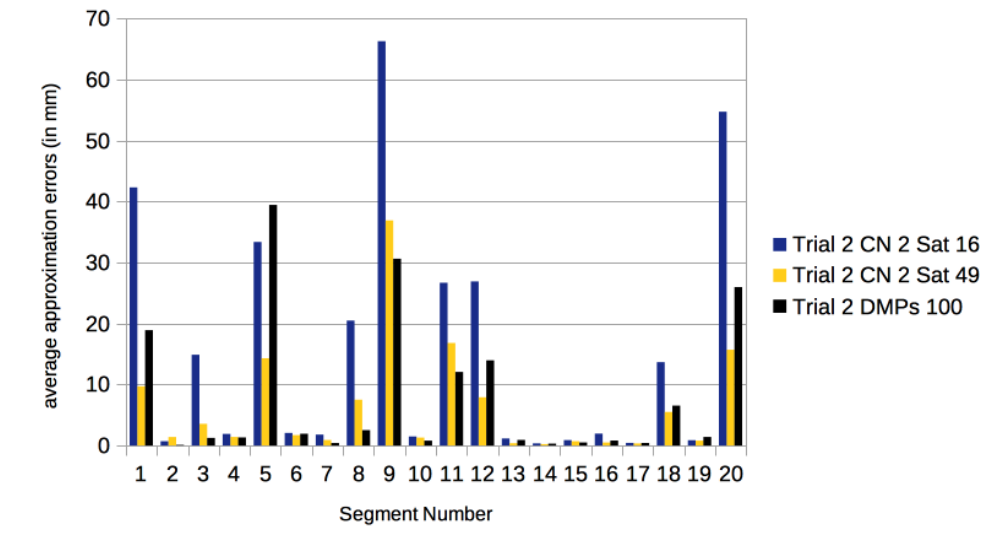
Figure 16. Approximation errors (in mm) for the algorithmically found segments of motions in CMU 86 Trial 2. We give the errors for using 16 satellites and 49 satellites. As a comparison we give the results using rhythmic DMPs with 100 basis functions computed with pydmps. The average over all segments is 8.0 mm for the DMPs, 15.6 mm for two centers and 16 satellites, and 6.3 mm for two centers and 49